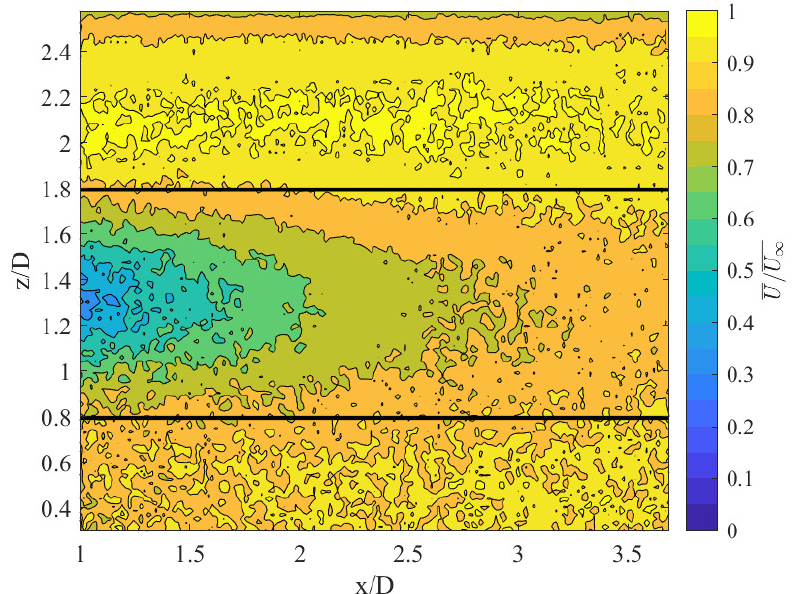
Figure 12. Contours of the normalized and temporally averaged freestream velocity with lines demarcating the area used for local averaging of wake